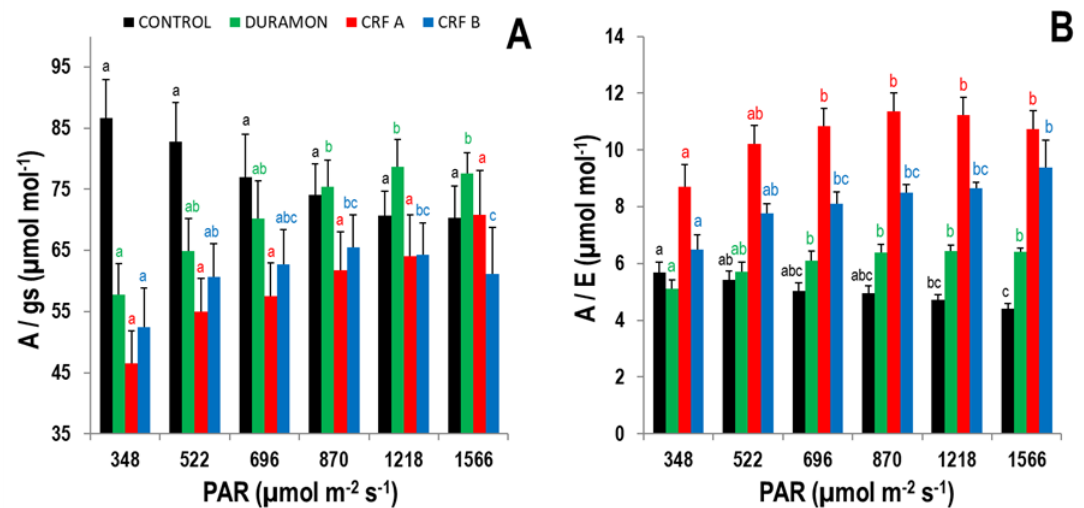
Figure 3. Water-use efficiency responses to different photosynthetically active radiation rates of Triticum aestivum treated with fertilizers CRF A , CRF B , DURAMON ® , and the CONTROL in the phenological state of panicles swelling (booting stage). ( A ) Water-use efficiency and ( B ) intrinsic water-use efficiency. Values represent means ± SE ( n = 6). Different letters for each treatment (same color) indicate statistically significant differences (ANOVA, P < 0.05).